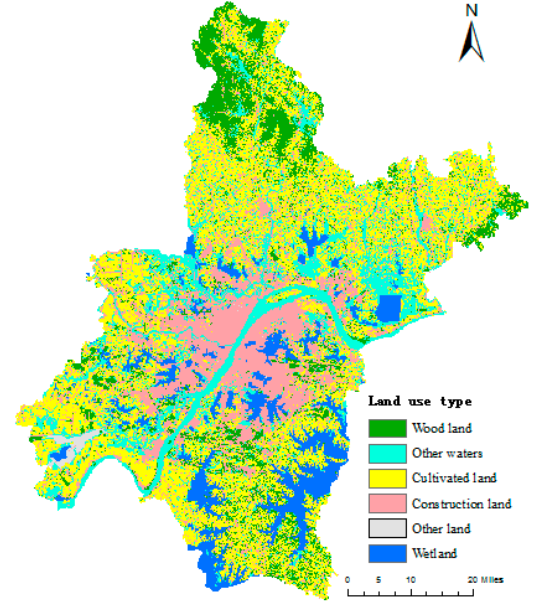
Figure 3. Land use types in Wuhan.